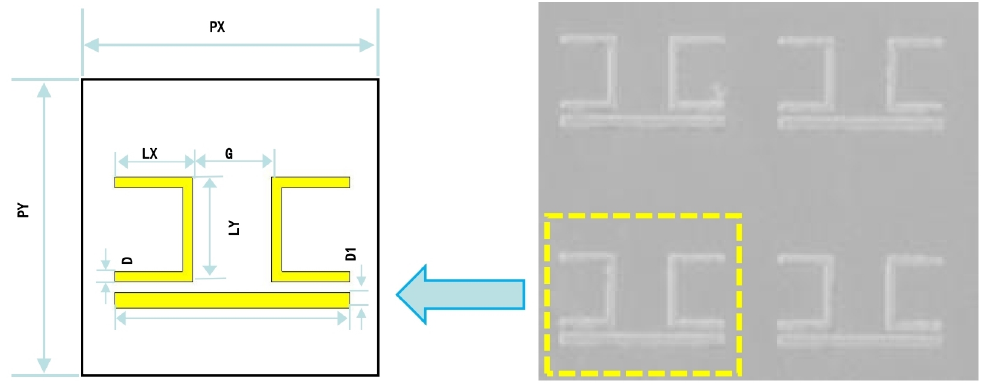
Figure 1. SEM image of the fabricated metamaterial